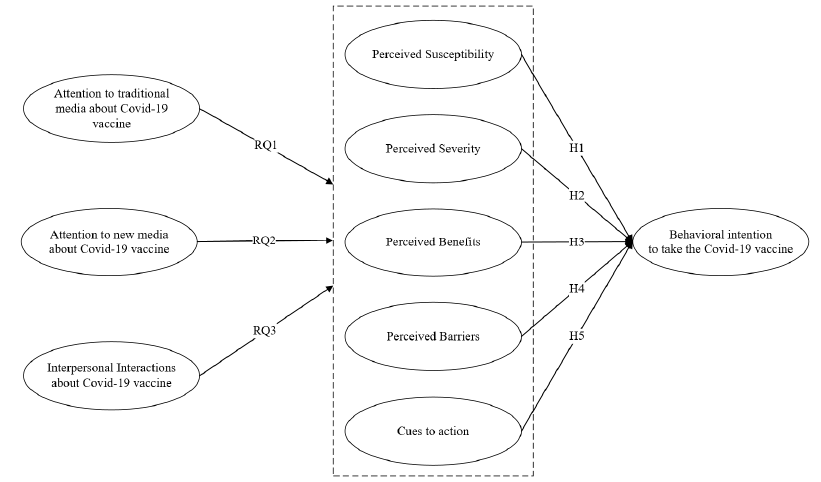
Figure 1. Hypothesized